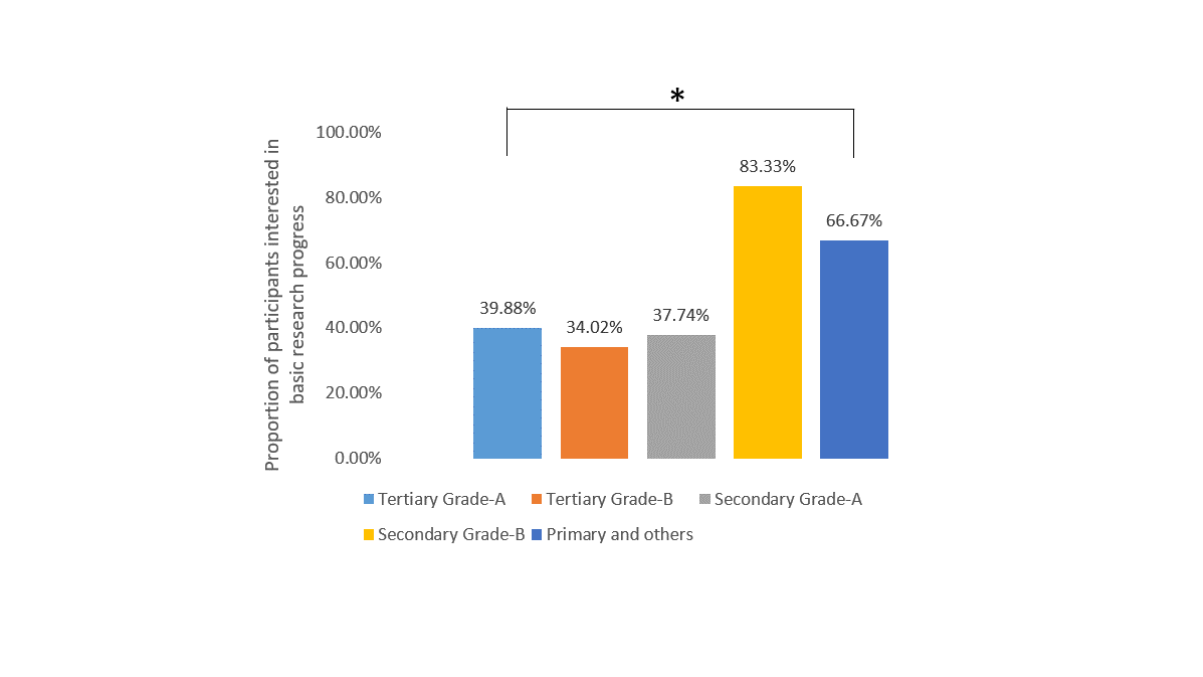
Figure 3. Proportions of participants interested in learning about basic research progress at urology conferences stratified by hospital level.* P ＞ .05.